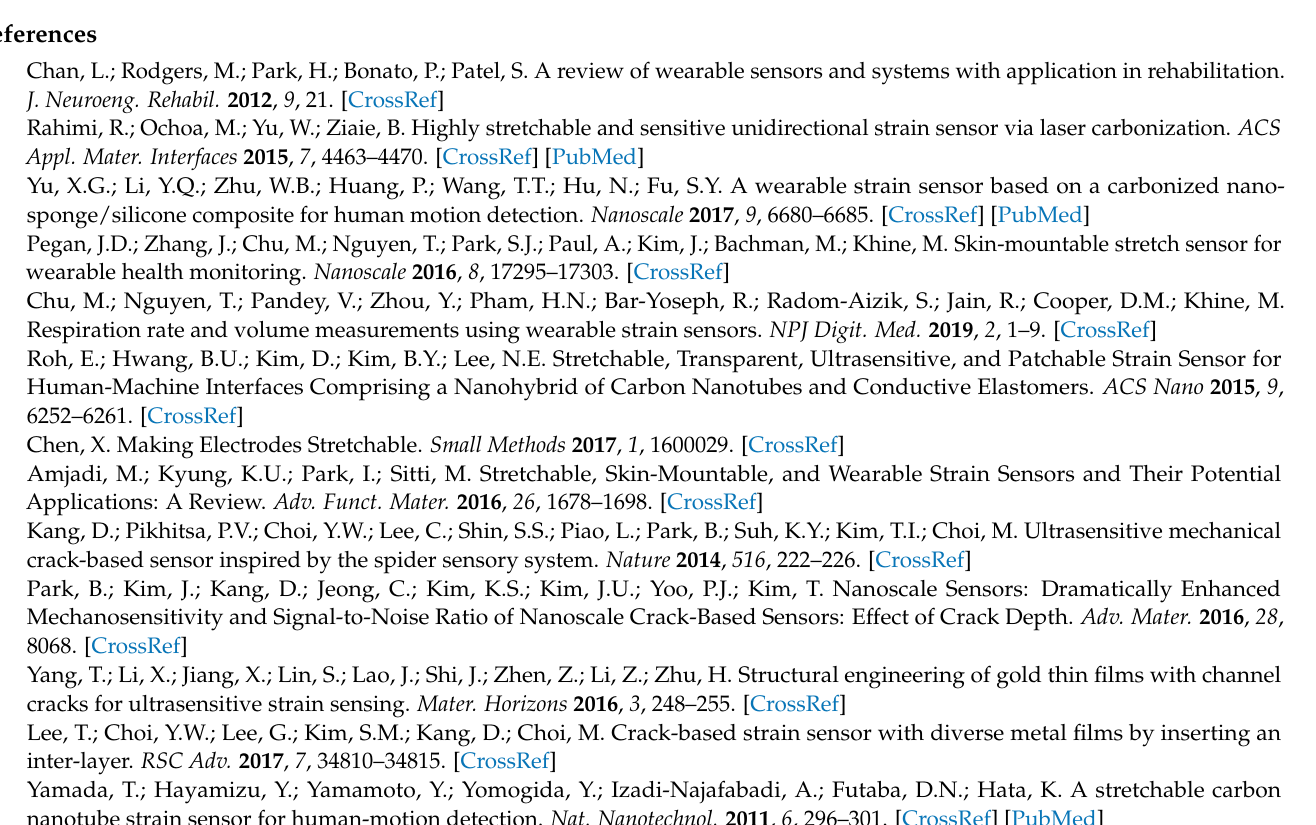
sensitivity curves for encapsulated sensors, Figure S5: Full cycling data without preconditioning, Figure S6: Full pre-fracture cycling data for an unencapsulated sensor, Figure S7: Full pre-fracture cycling data for an encapsulated sensor, Figure S8: Full post-fracture cycling data for an unencap- sulated sensor, Figure S9: Full post-fracture cycling data for an encapsulated sensors, Figure S10: Comparison of total surface area ratio of cracks to metal within the same field of view, Figure S11: Plot of mean number of cracks for statistical comparison, Figure S12: Distribution of crack size (crack area µ m 2 ) for the pre-fractured unencapsulated film across strain points, Figure S13: Distribution of crack size (crack area µ m 2 ) for the pre-fractured encapsulated film across strain points, Figure S14: Distribution of crack size (crack area µ m 2 ) for the post-fractured unencapsulated film across strain points, Figure S15: Distribution of crack size (crack area µ m 2 ) for the post-fractured encapsulated film across strain points. Multivariate analysis R code: Supplemental_crack_analysis_final.Rmd Details on multivariate analysis: